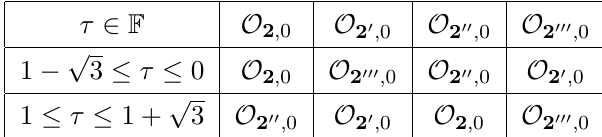
(cid:0)p 3 (cid:20) (cid:28) (cid:20) 0 and 1 (cid:20) (cid:28) (cid:20) 1+